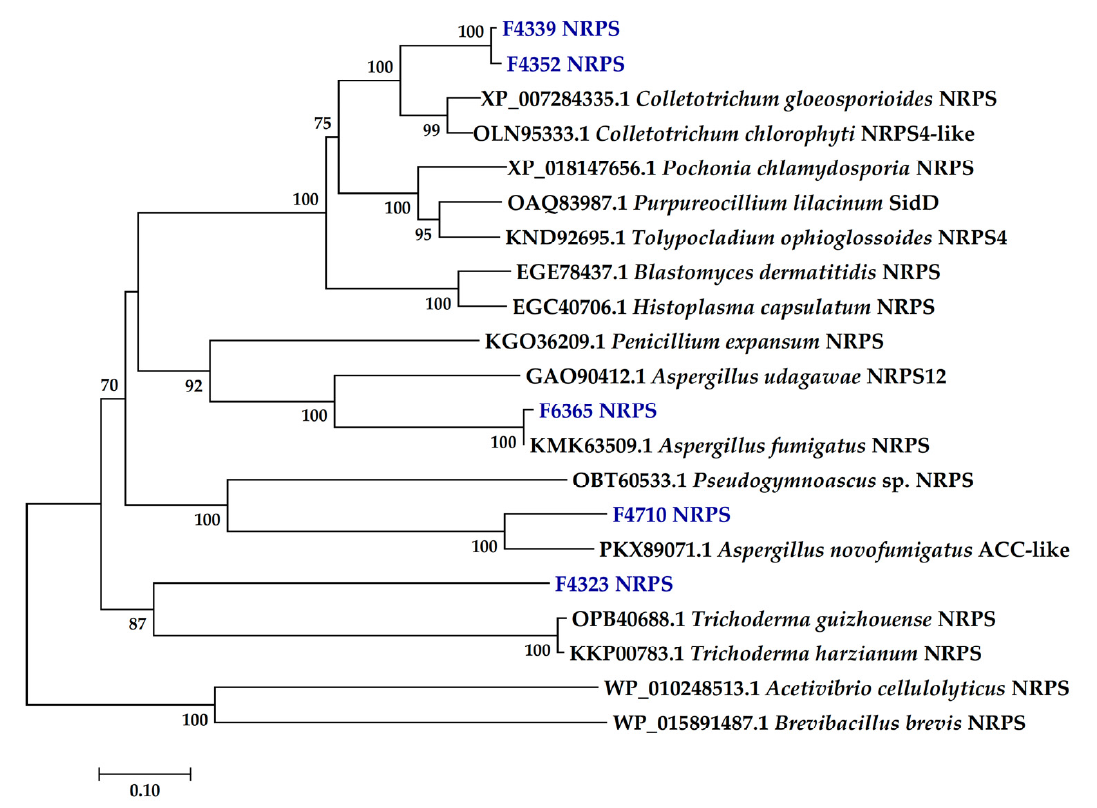
Figure 3. The phylogenetic tree of fungal nonribosomal peptide synthetases (NRPS) detected in this study (shown in blue). GenBank accession numbers are shown beside each reference entry. NRPSs from two bacteria; Acetivibrio cellulolyticus and Brevibacillus brevis were used as outgroups. Evolutionary relationships were determined by the neighbor-joining method, and bootstrap values of ≥ 50% are shown above the nodes. The scale bar represents 0.1 amino acid changes.